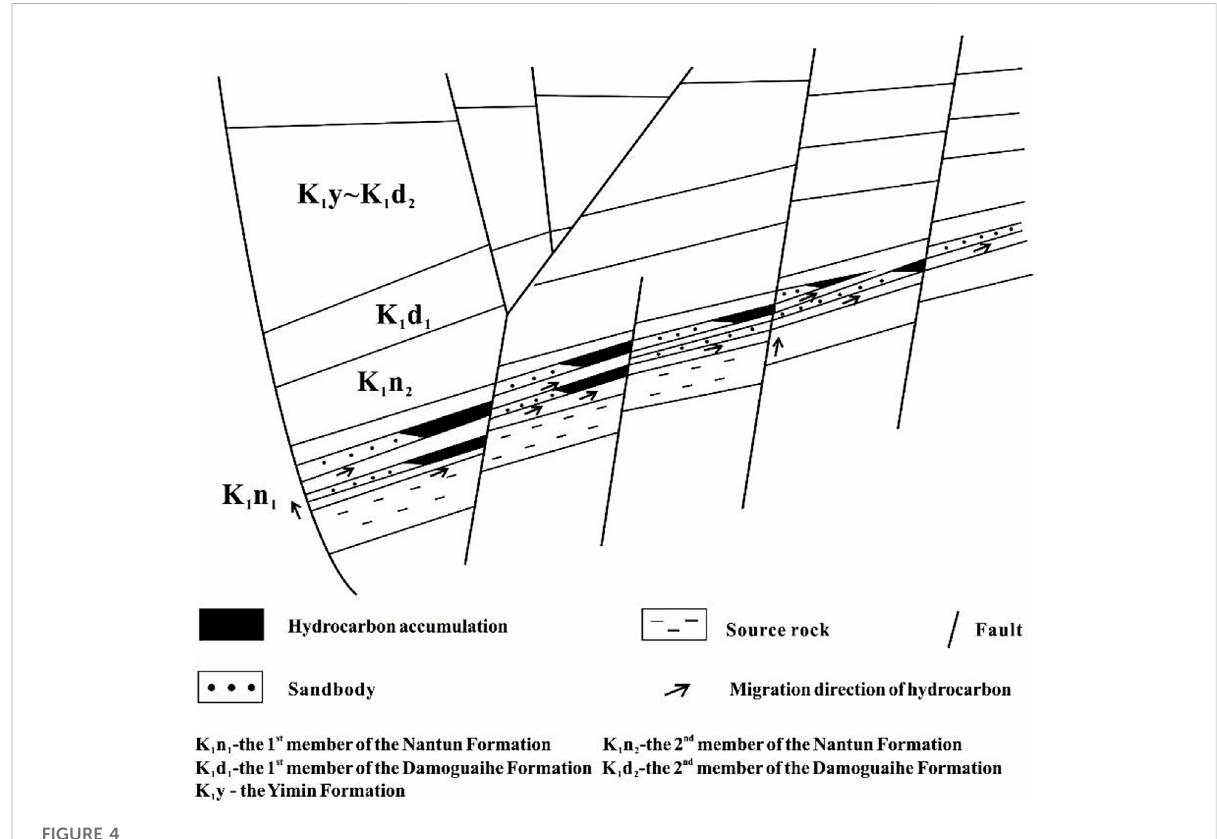
Schematic of the hydrocarbon accumulation model for the fi rst member of the Nantun Formation (K 1 n 1 ) in the Wunan slope